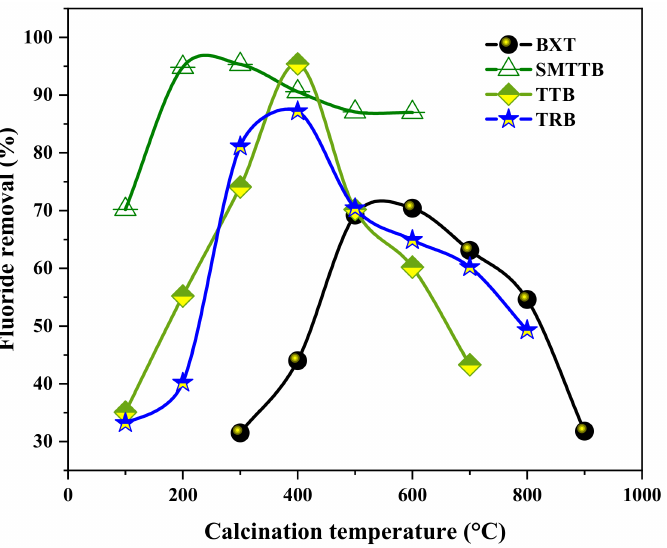
Figure 1. Effect of activation temperature of bauxite on fluoride recovery. Data collected from references